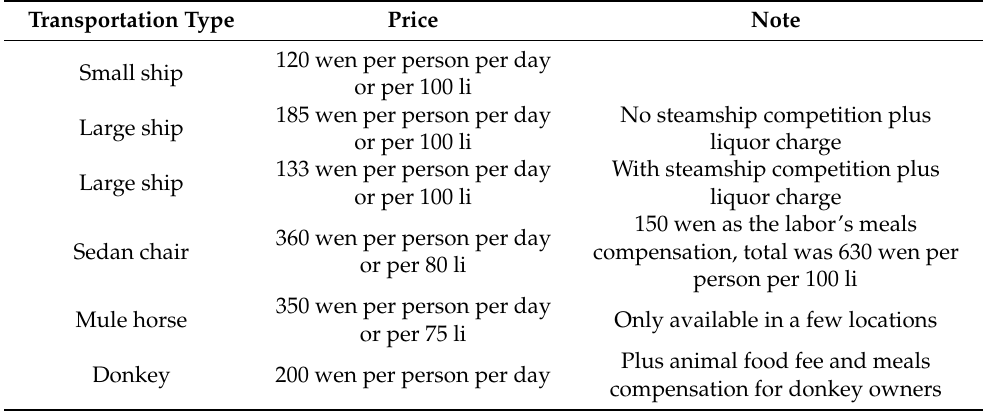
Table 2. Price list of freight transport in the Jiangnan region of China at the end of the 19th century. Transportation Type Price Note 1000 wen per 100 dan per There was a discount for a longer Small ship day or per 100 li distance of approximately 800 wen The freight owners paid the tax themselves, along with the fees for Large ship 5.1 wen per dan or per 100 li the shipowner as wine, writing the contract, and burning the incense bar 360 wen per dan per day or Carrying pole Meals compensation: 150 wen per day per 80 li 300 to 350 wen per 2 dan per Animal food fee and meals Mule horse day or per 75 li compensation: 150 wen 200 to 300 wen per dan per Animal foods fee and meals Donkey day or per 75 li compensation for donkey